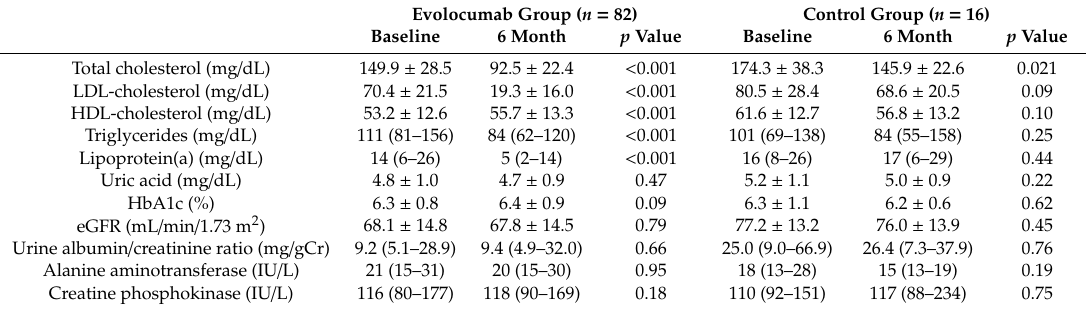
Table 5. Laboratory parameters before and 6 months after the baseline in the evolocumab and control